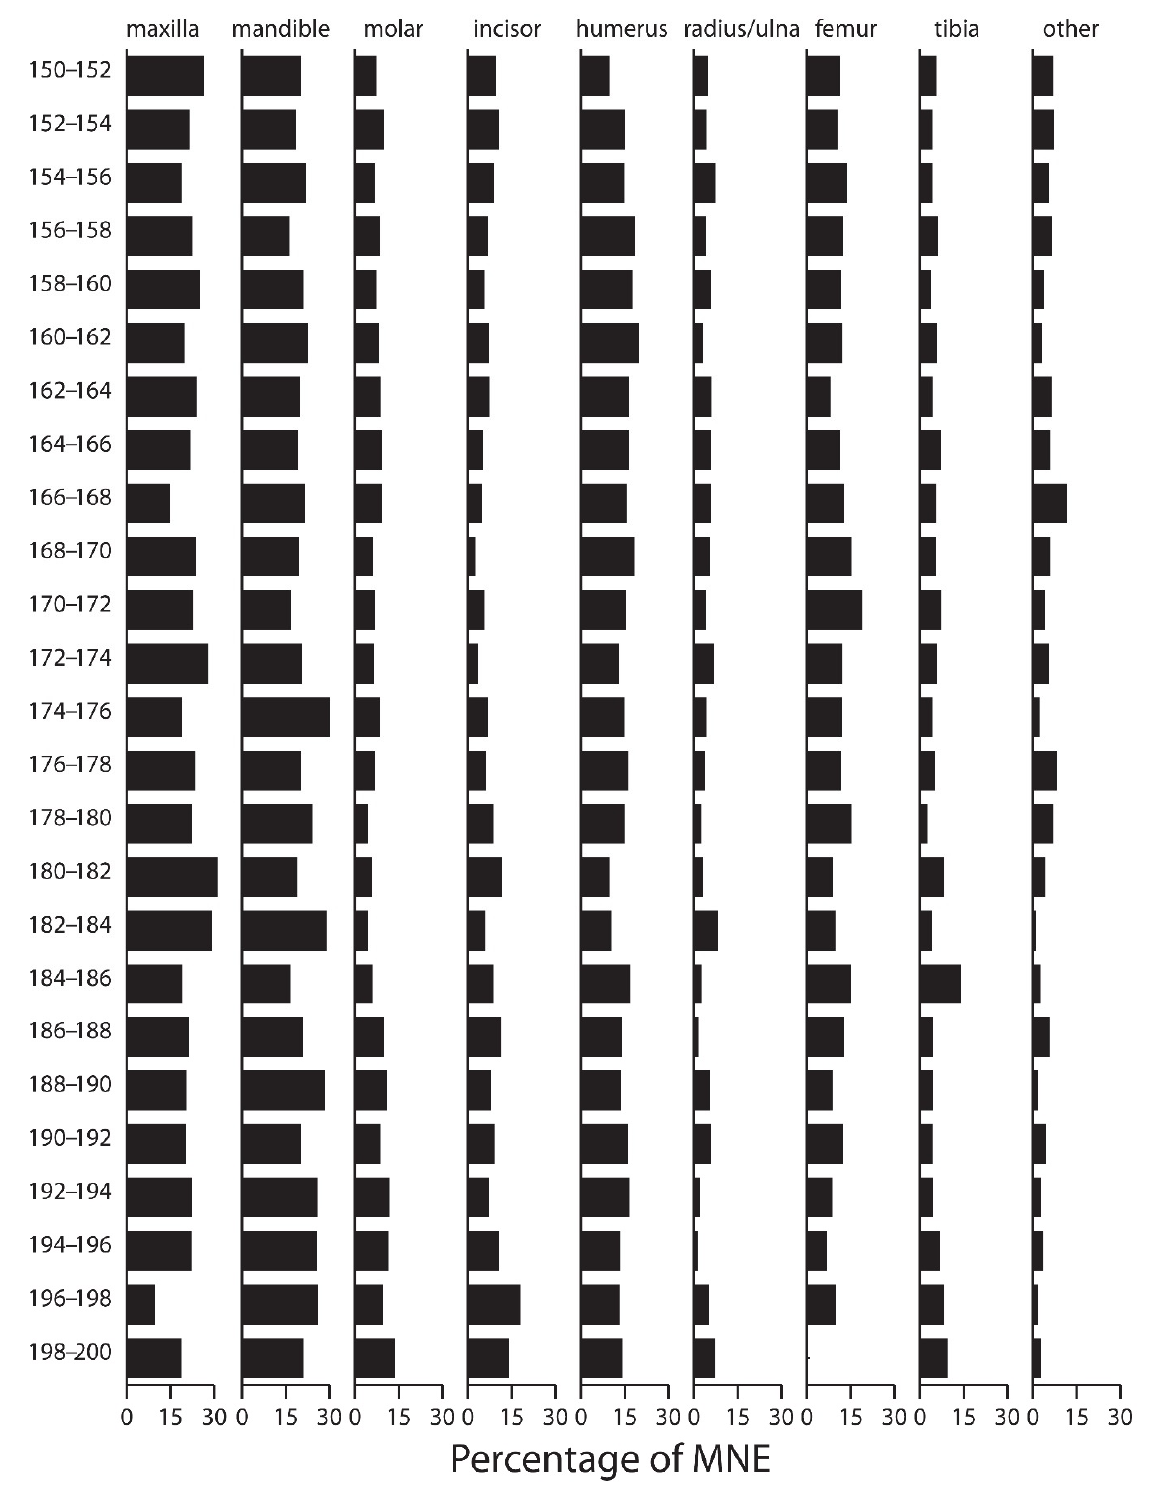
Figure 3. Skeletal part representation of micromammals by spit (cm), expressed in percentage of MNE (Minimum Number of Elements). Spits 200–214 are not represented due to the small size of the